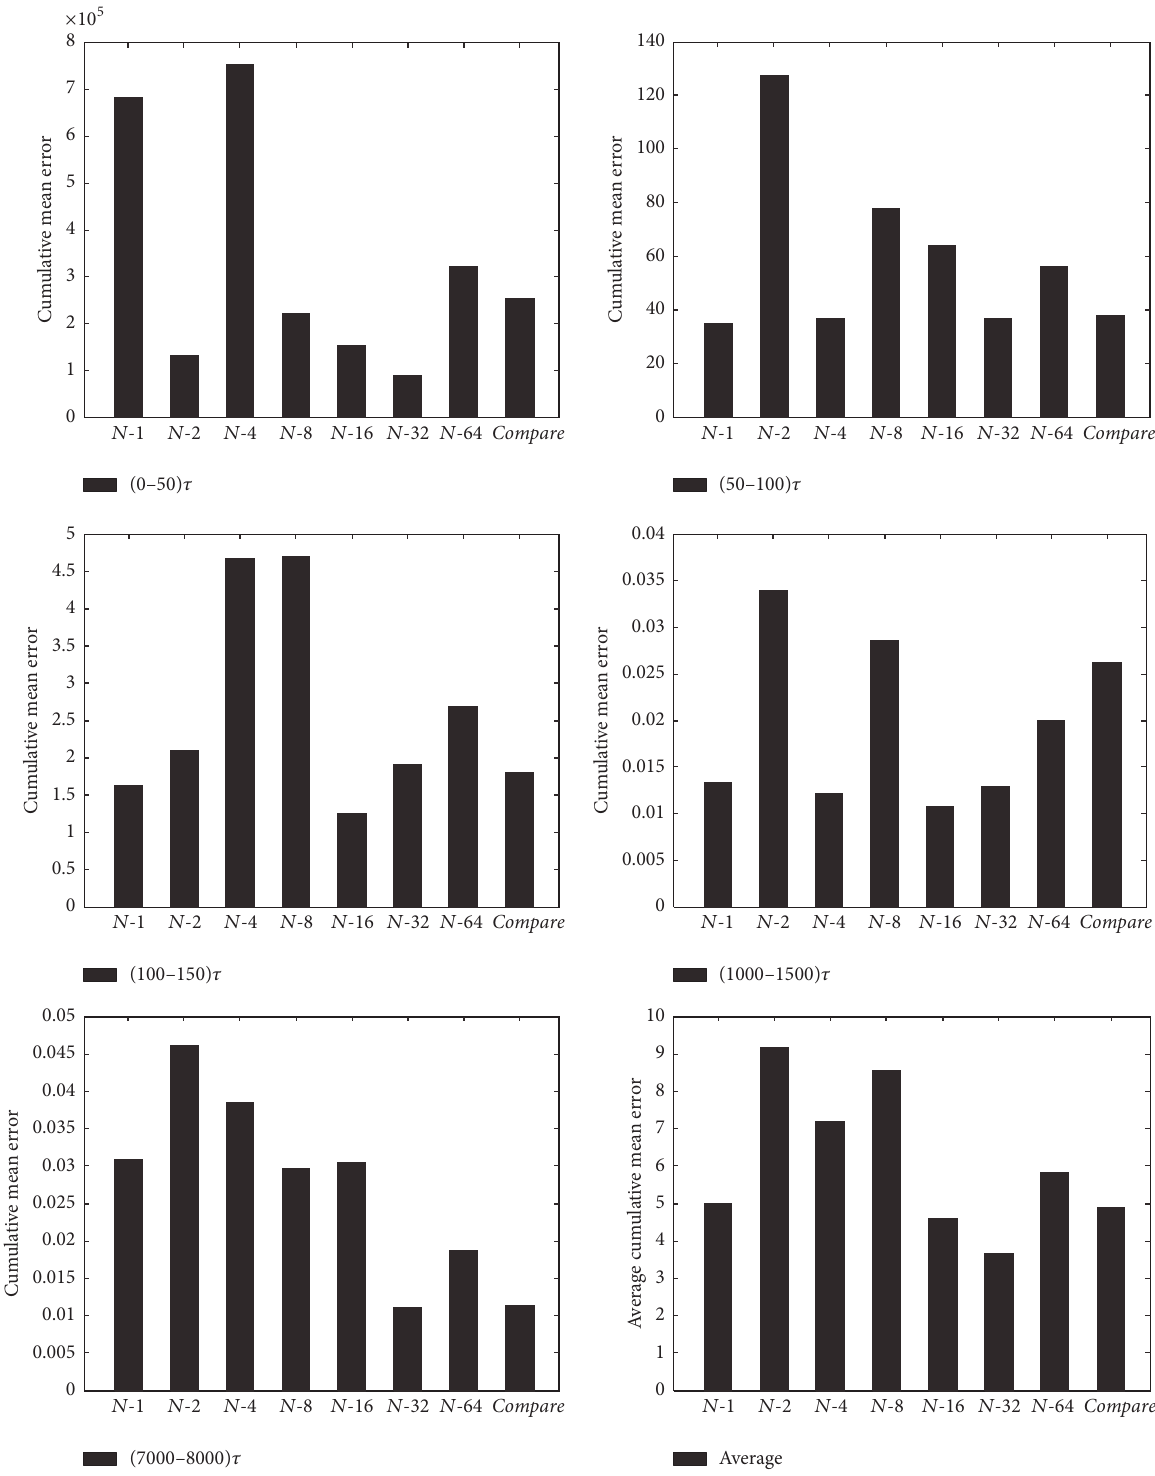
Figure 12: Cumulative mean errors during five time intervals (0–50) 𝜏 , (50–100) 𝜏 , (100–150) 𝜏 , (1000–1500) 𝜏 , and (7000–8000) 𝜏 and final average